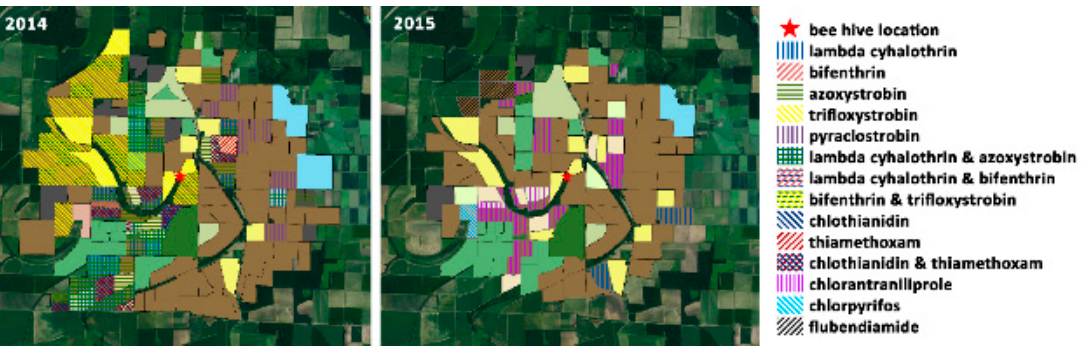
Figure 6. Reported distribution of foliar applied pesticides in the surveyed area within the High-Ag survey area during the 2014 and 2015 growing seasons.